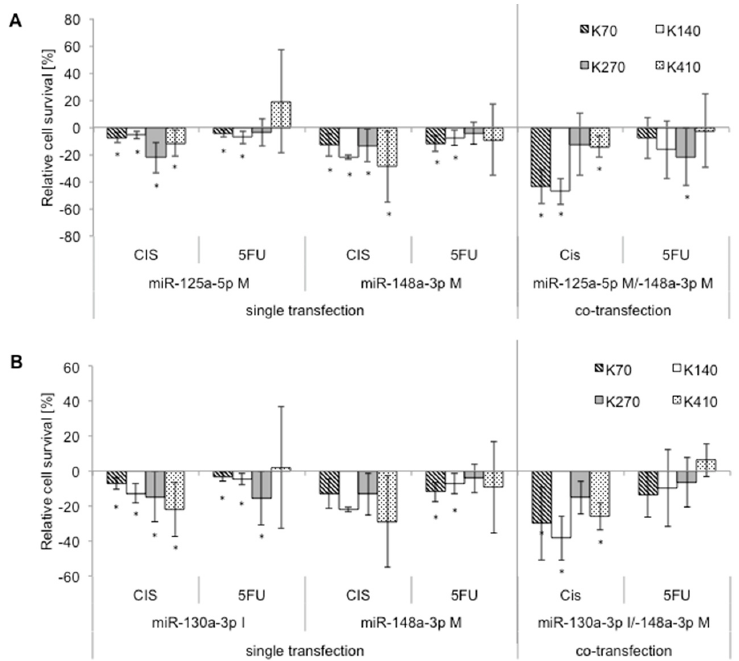
Figure 2. Co-transfection: additive effects of resistance-relevant miRNAs. Effect of co-transfection of miRNAs on cytotoxicity after chemotherapy treatment for: ( A ) miR-125a-5p mimic/miR-148a-3p mimic, and ( B ) miR-130a-3p inhibitor/miR-148a-3p mimic, compared to single transfection controls with each miRNA. Relative cell survival compared to controls given in %, controls set to “zero”. K70: KYSE-70; K140: KYSE-140; K270: KYSE-270; K410: KYSE-410; CIS: cisplatin; 5-FU: 5-fluorouracil; M: mimic; I: inhibitor; and *: significance ( p ≤ 0.05).